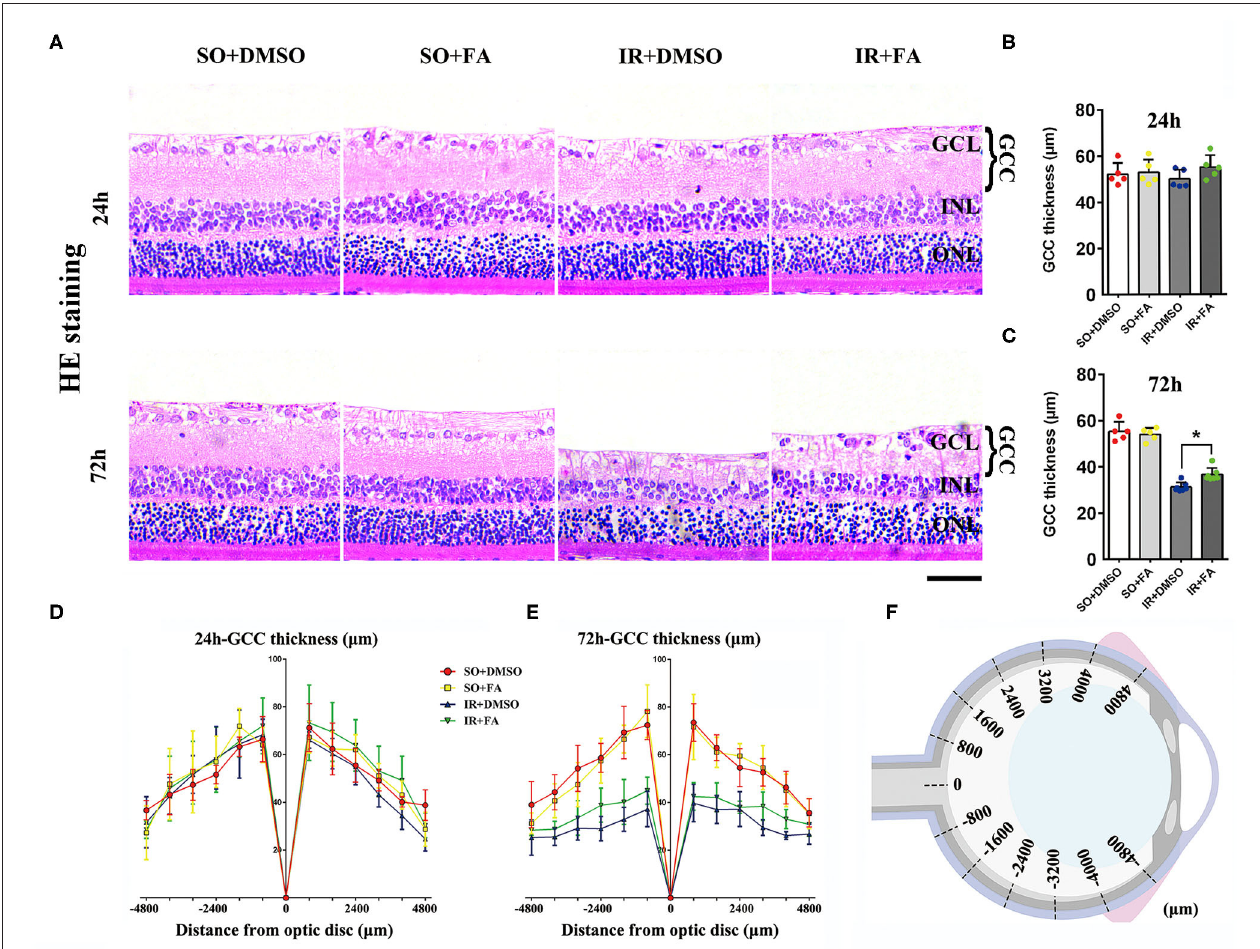
FIGURE 3 | PPAR α activation by FA mitigates GCC thinning in IR rats. (A) Representative photomicrographs of HE-stained retinal slices taken at 2,400 µ m away from the optic nerve at 24 and 72h post-IR modeling. (B,C) Mean thickness of the GCC at 24 h/72h post-IR modeling. (D,E) At 24 and 72h after modeling, the GCC thickness of rats was measured ± 800, ± 1,600, ± 2,400, ± 3,200, ± 4,000, and ± 4,800 µ m away from the optic nerve. (F) The diagrammatic picture of GCC measured in the retina. Data are the mean ± SEM; * p < 0.05. Scale bar = 50 µ